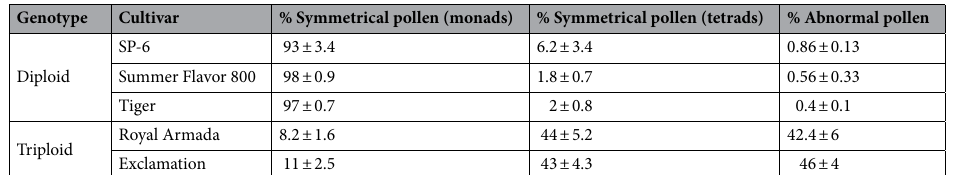
Table 1. Pollen grain characteristics of five watermelon cultivars as the percentage of abnormal pollen, symmetrical pollen as tetrads and monads per flower (percentage ±